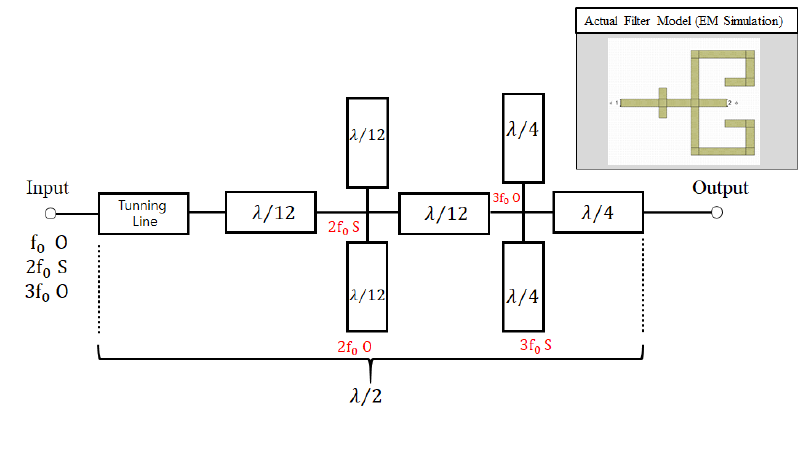
Figure 4. Harmonic termination filter using open-ended